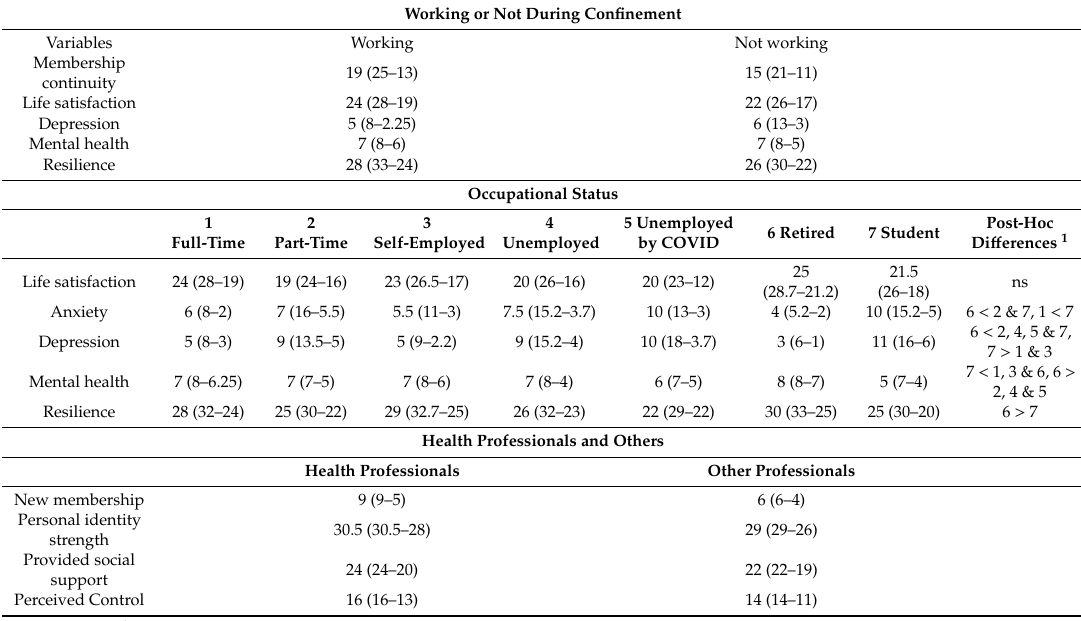
Table 5. Descriptives (Md (IQR)) and post-hoc di ff erences by working and occupational status.